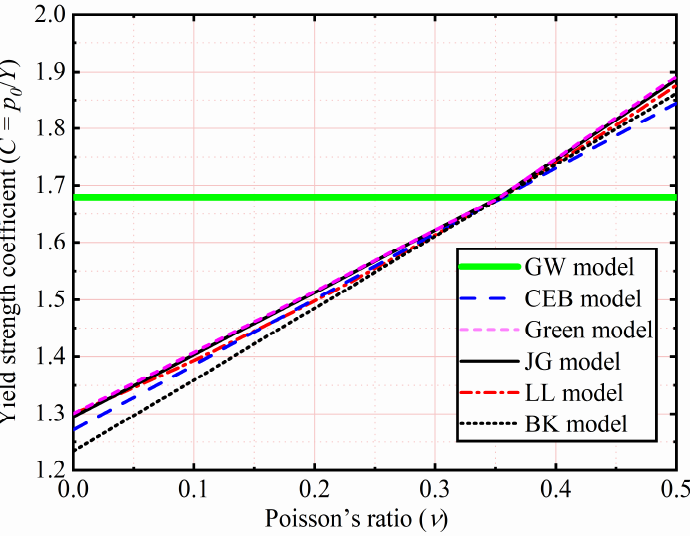
Figure 2. Yield strength coefficient as a function of Poisson’s ratio.